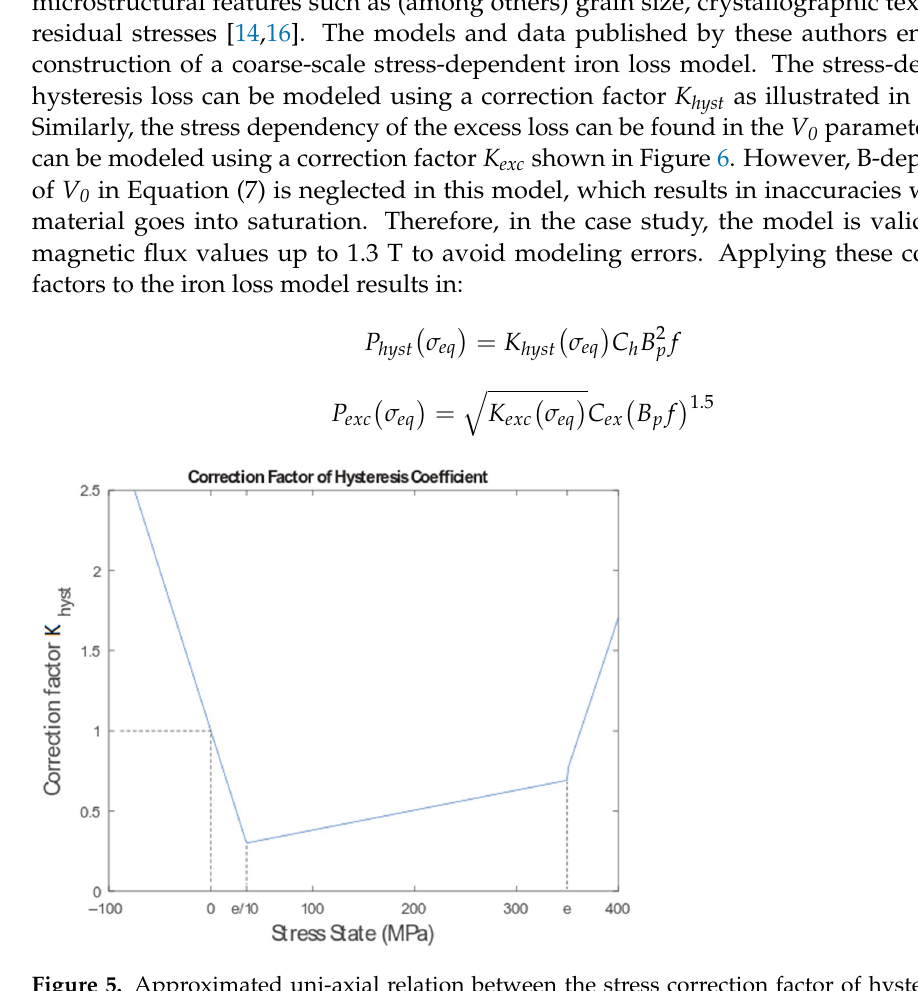
Figure 5. Approximated uni-axial relation between the stress correction factor of hysteresis loss coefficient K hyst and the stress state [14]. K hyst reaches a minimum of 0.3 at a stress of 10% of the material elastic limit e. This figure is valid for a material with elastic limit = 350 MPa.